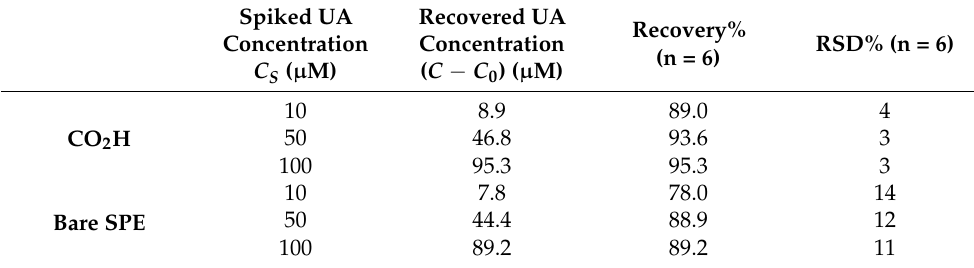
Table 5. Determination of UA concentrations in spiked urine samples.